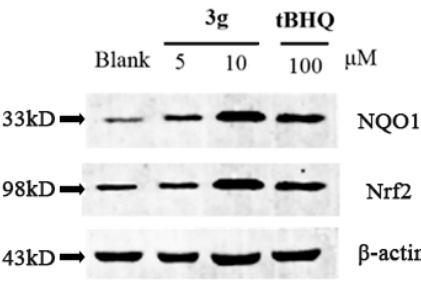
Figure 2. 3g can elevate the protein level of Nrf2 and NQO1.